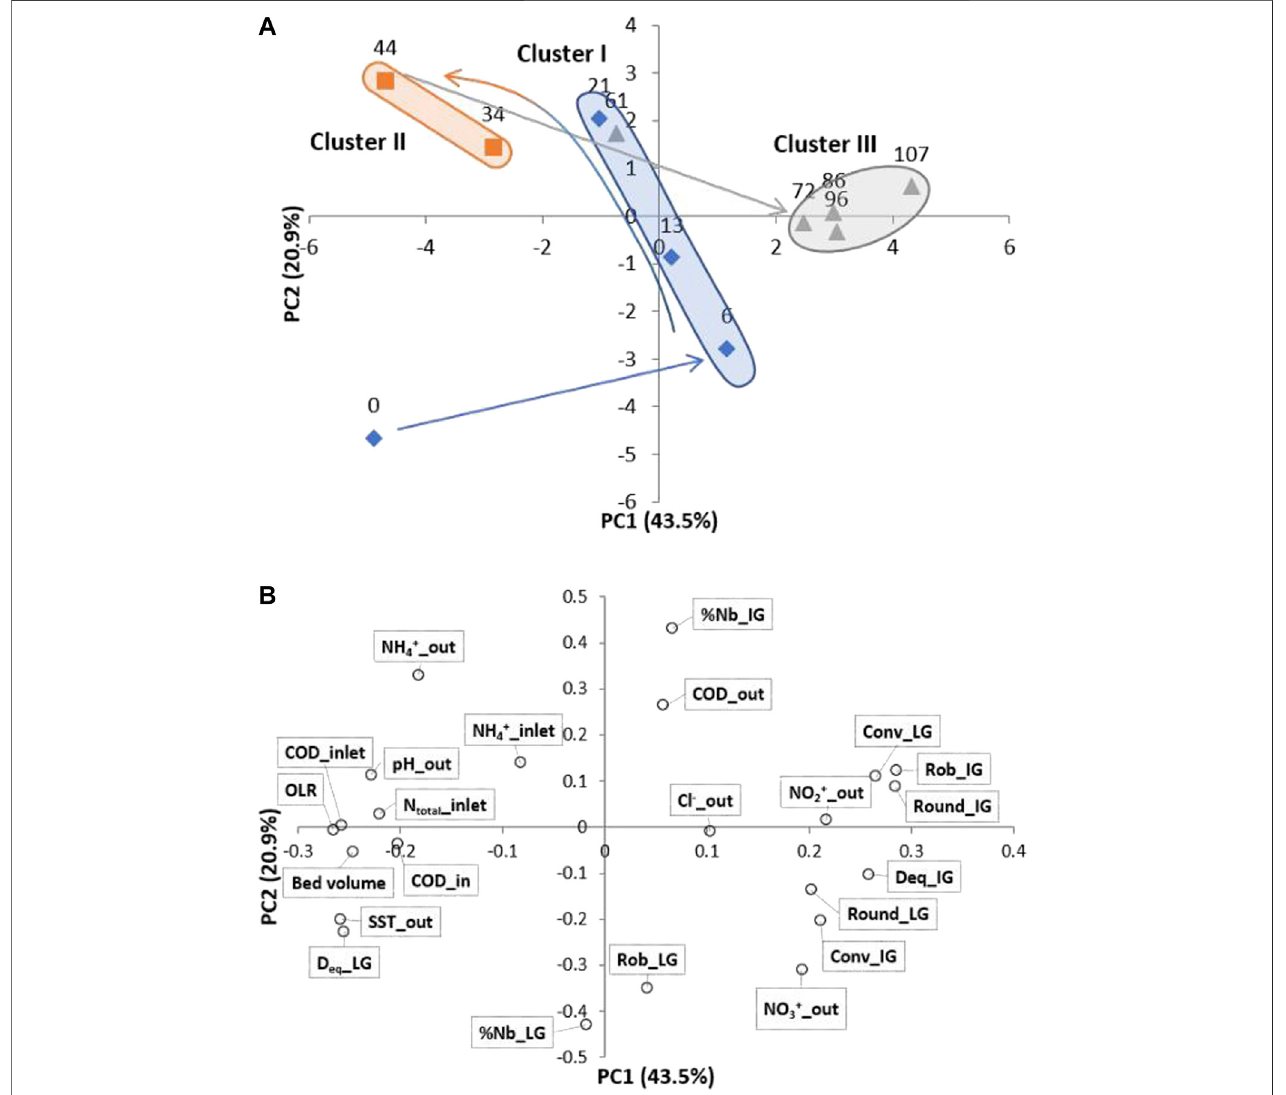
FIGURE3| PCAwiththemainQIAdataandphysicochemicalparametersfromoperationaldayscorrespondingto:phaseI(day0,day6,day13,day21)( ◊ ),phase II(day34,day44) ( ■ ) andphaseIII (day61,day72,d86,day 96,day107) ( ▲ ) oftheAGSprocess; (A) Operational periodsand (B) QIAandphysicochemicaldata.Note: PC1 and PC2 explain 43.5 and 20.9% of the dataset variance, respectively.